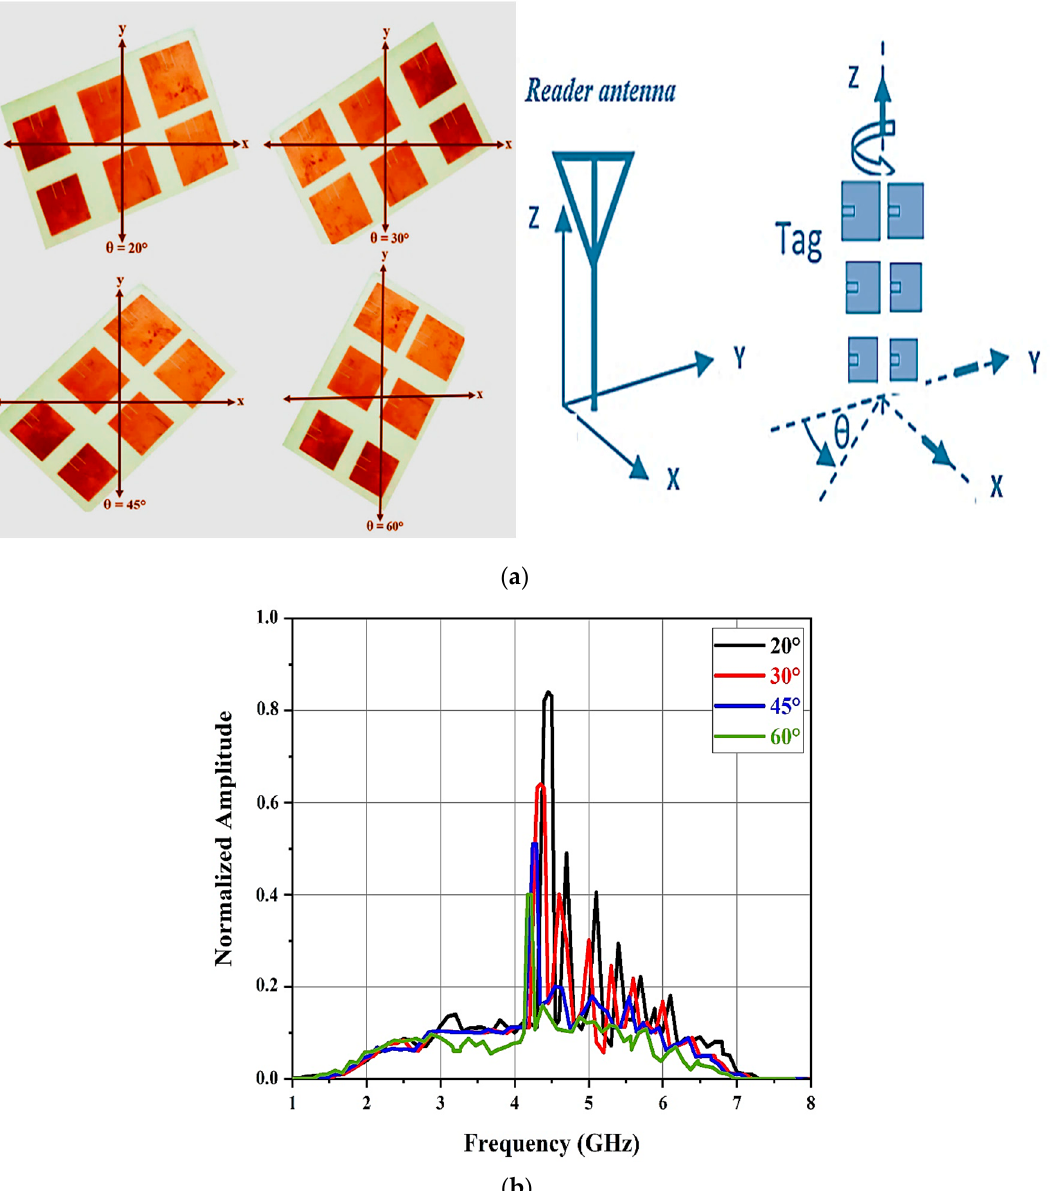
Figure 14. ( a ) Position of the tag with respect to the RFID reader and ( b ) normalized amplitude spectrum of the antenna mode backscatter for different tag